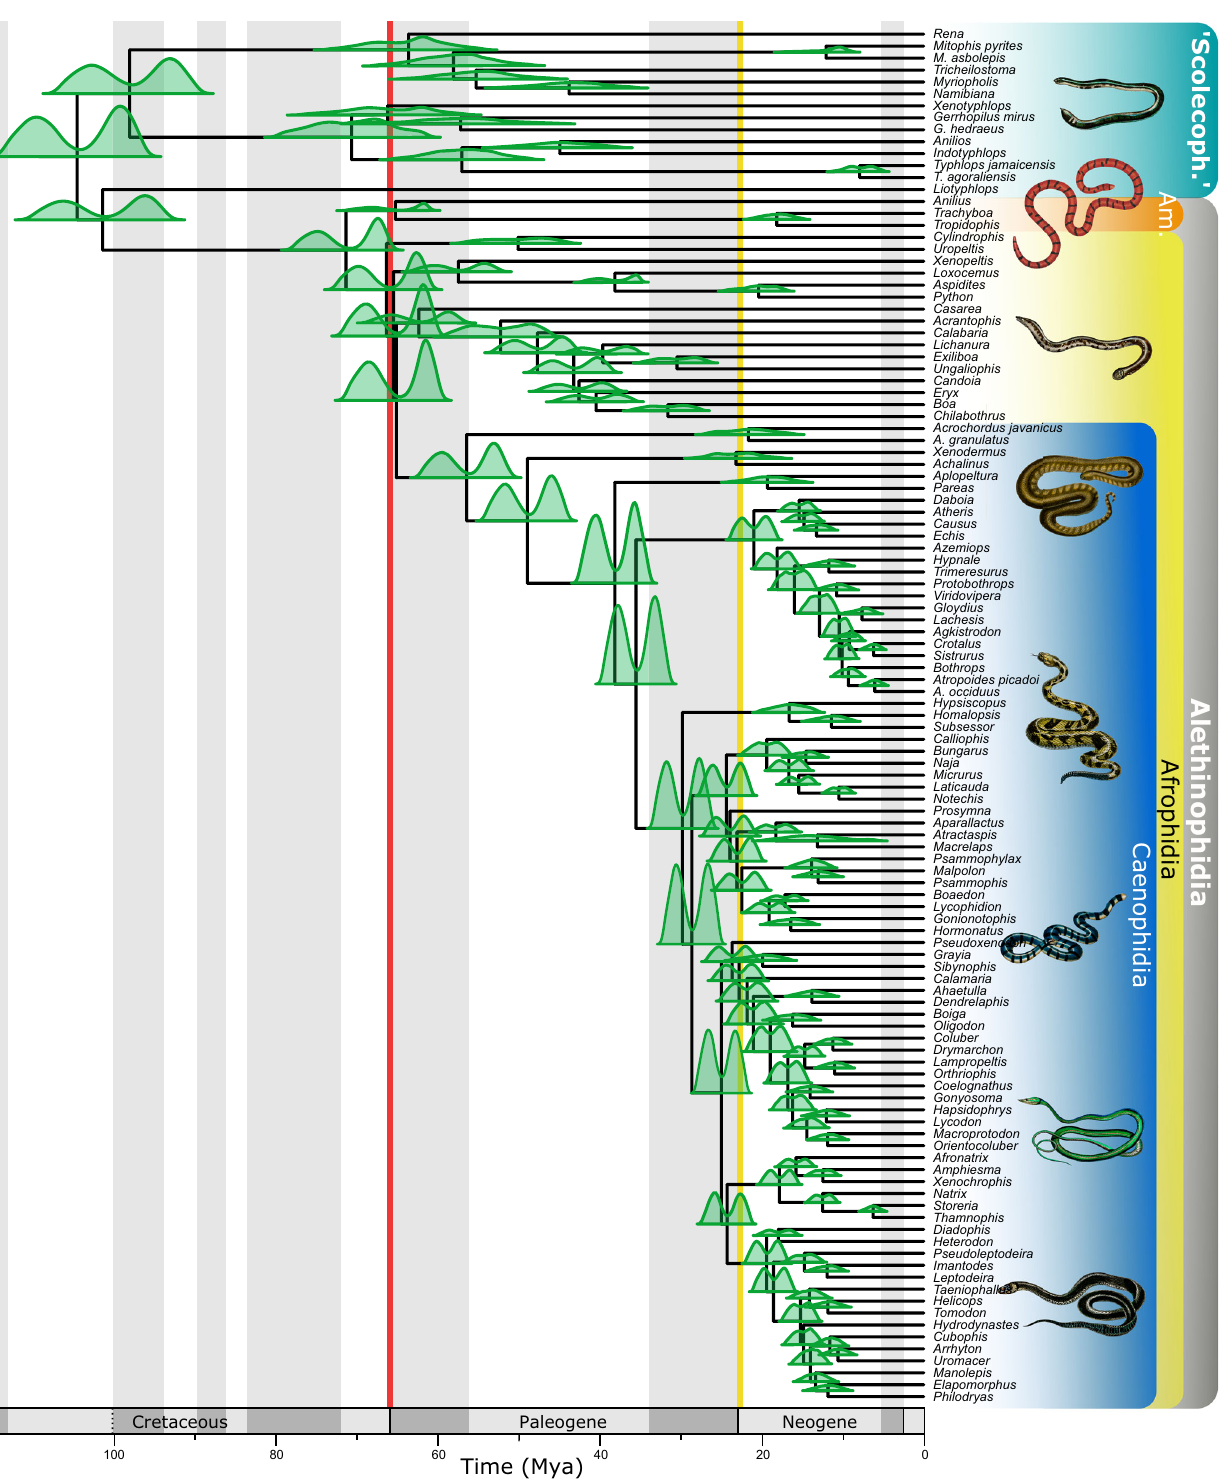
Fig. 1 Time-calibrated phylogeny of crown snakes based on the 42 fossil calibration set developed in this study, under a Bayesian Inference framework. Green curves represent concatenated posterior age estimates for ingroup nodes using a skew-T and skew-Normal prior. Major clades discussed in the main text are shown on the right; Scolecoph., Scolecophidia; Am., Amerophidia. The K-Pg boundary is indicated by a red line and the Oligocene-Miocene boundary by a yellow